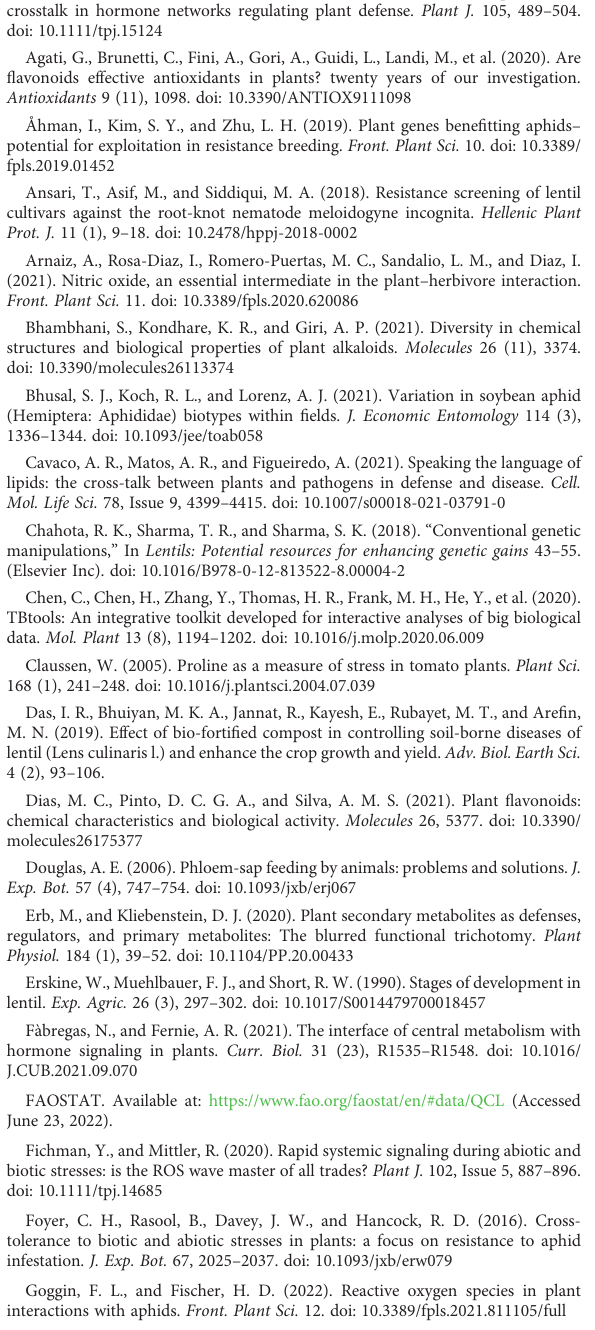
SUPPLEMENTARY FIGURE 2 PCA (Ai, Bi), PLS-DA (Aii, Bii) score plots and permutation tests (Aiii, Biii) from the comparison of lentil samples after 48 h of treatment (red) with control samples (black) employing UHPLC-HRMS analysis in negative (A)